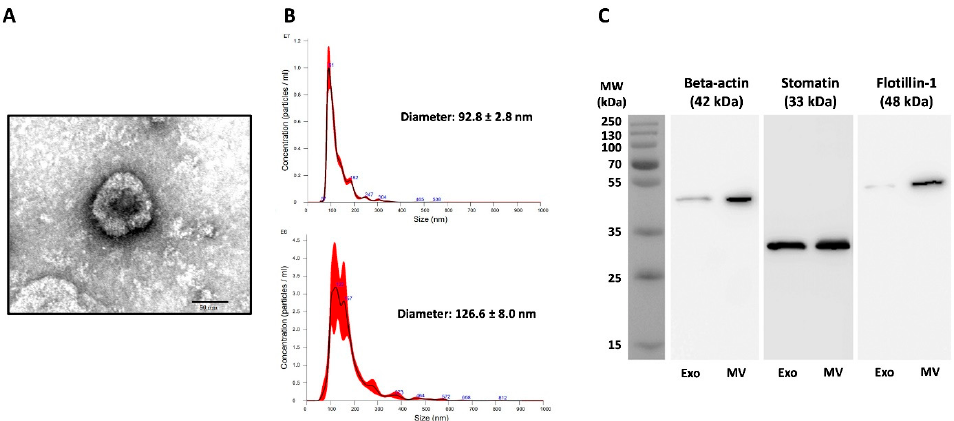
Figure 1. Characteristics of Pf -EVs isolated from supernatants of P. falciparum cultures. Exo, exosome; MV, microvesicle. ( A ) Representative TEM of Pf -Exo from P. falciparum 3D7. Image presents negatively stained Pf -Exo, imaged by TEM at amplification of 80,000X; the bar represents 50 nm. ( B ) Representative NTA results of Pf -Exo ( top ) and Pf -MV ( bottom ) from P. falciparum 3D7. ( C ) Representative Western blot of β -actin, stomatin, and flotillin-1 in Pf -Exo ( left lane ) and Pf -MV ( right lane ) from P. falciparum 3D7-infected RBCs.